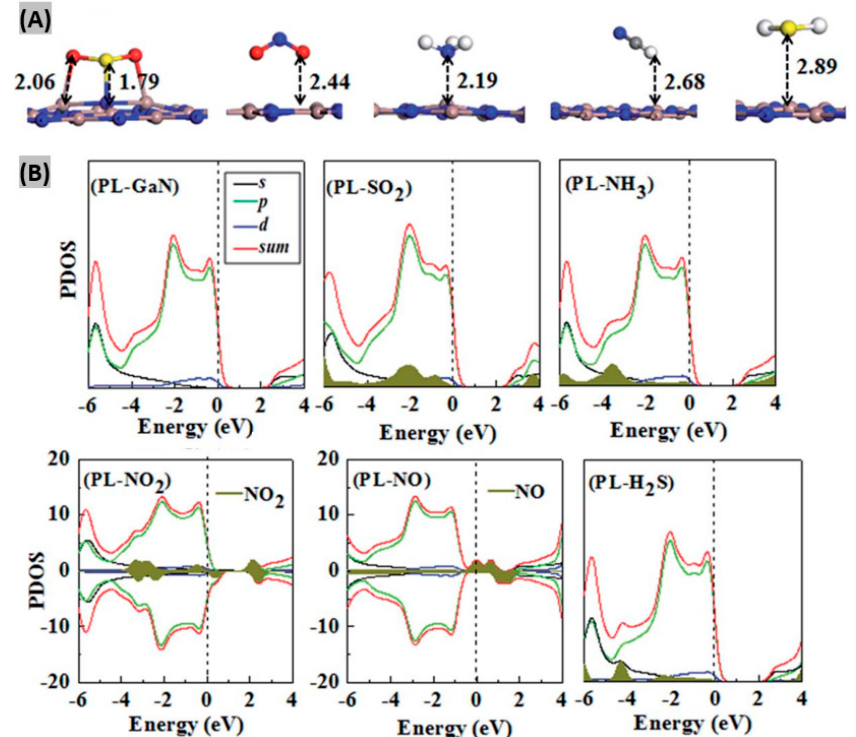
Figure 8. ( A ) The most stable structures of the PL-GaN sheet with gas molecule adsorption, (From left) SO 2 , NO 2 , NH 3 , HCN and H 2 S. Adsorption distances are presented in Å. Ga, N, S, O, C and H atoms are brown, blue, yellow, red, grey and white, respectively. ( B ) Total and partial density of states (DOS) of the most stable structures of the PL-GaN sheet and its adsorption systems with SO 2 , NH 3 , NO 2 , NO, and H 2 S. Fermi-level energy is indicated by vertical dashed line. Figures adapted with permission from [74], Copyright 2017 The Royal Society of Chemistry.